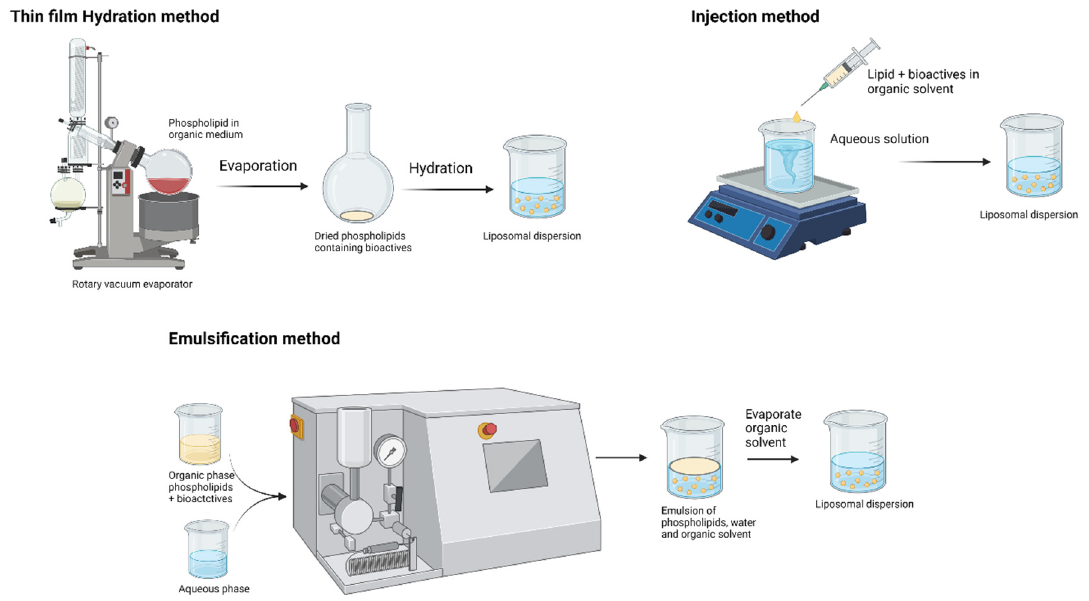
Figure 4. Production techniques of liposomes (created with